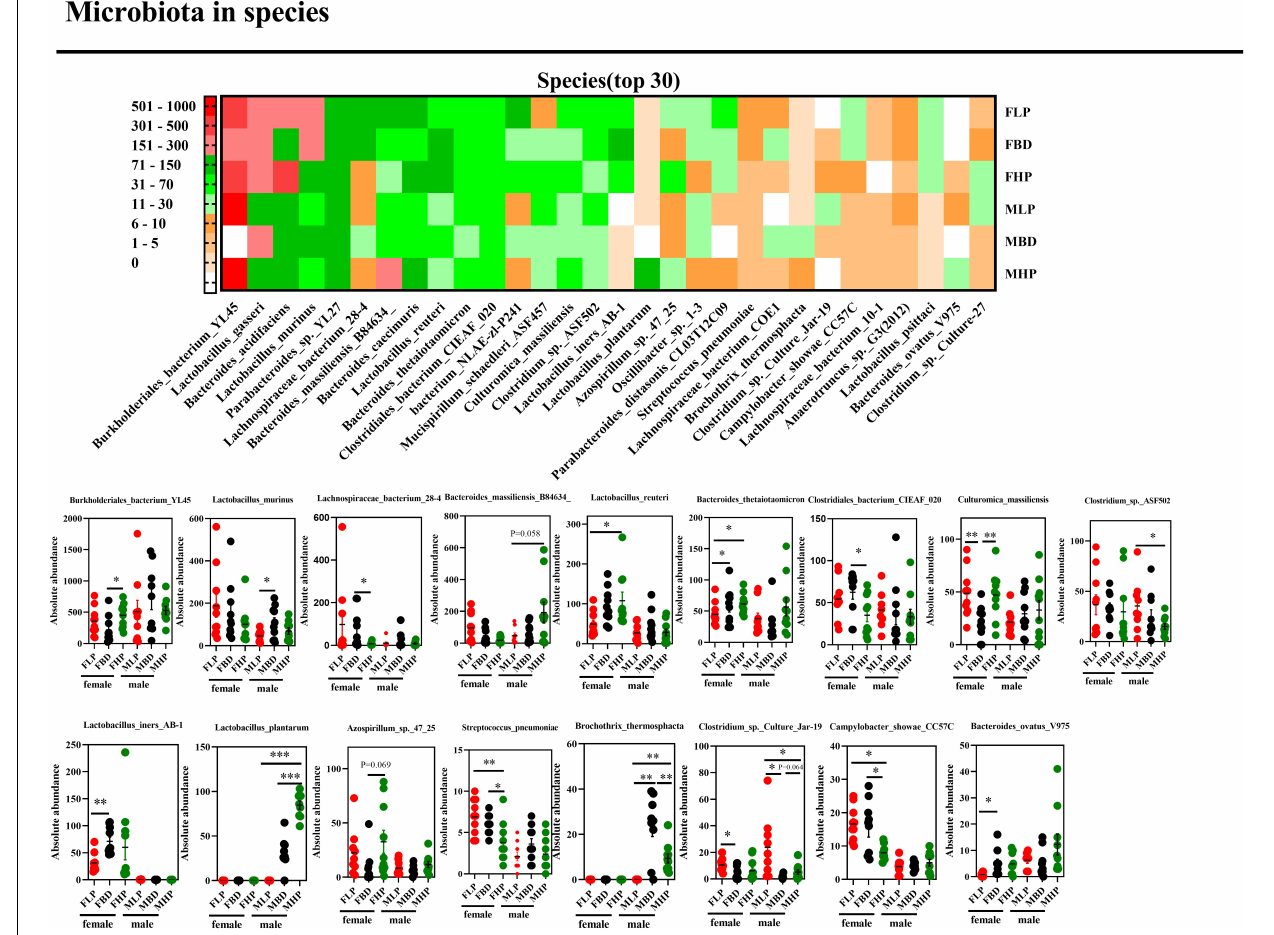
FIGURE 6 | Effects of diets with different protein levels on species-level bacteria in the fecal microbiota of